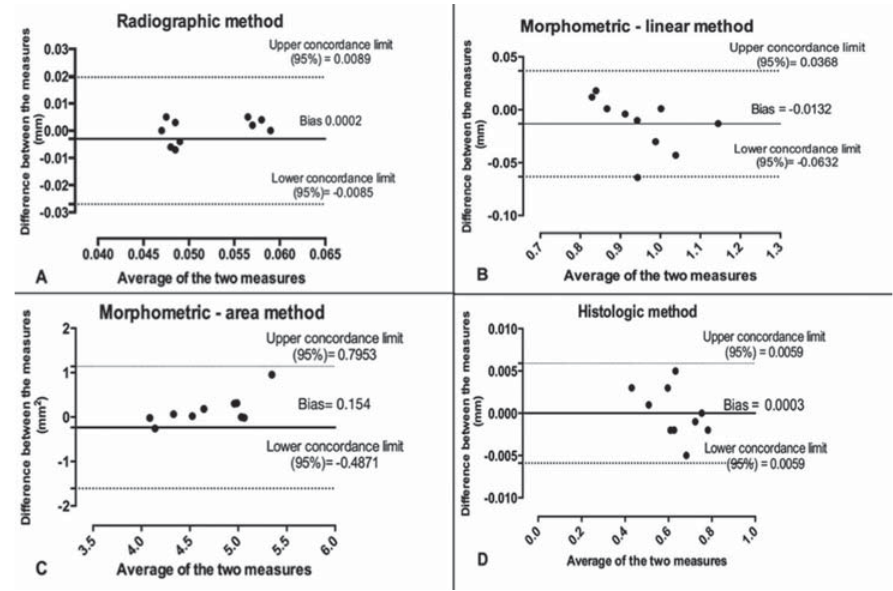
Figure 4- (cid:3)(cid:37)(cid:79)(cid:68)(cid:81)(cid:71)(cid:177)(cid:36)(cid:79)(cid:87)(cid:80)(cid:68)(cid:81)(cid:182)(cid:86)(cid:3)(cid:87)(cid:72)(cid:86)(cid:87)(cid:3)(cid:11)(cid:76)(cid:81)(cid:87)(cid:85)(cid:68)(cid:16)(cid:72)(cid:91)(cid:68)(cid:80)(cid:76)(cid:81)(cid:72)(cid:85)(cid:3)(cid:72)(cid:89)(cid:68)(cid:79)(cid:88)(cid:68)(cid:87)(cid:76)(cid:82)(cid:81)(cid:12)(cid:29)(cid:3)(cid:11)(cid:36)(cid:12)(cid:3)(cid:85)(cid:68)(cid:71)(cid:76)(cid:82)(cid:74)(cid:85)(cid:68)(cid:83)(cid:75)(cid:76)(cid:70)(cid:3)(cid:80)(cid:72)(cid:87)(cid:75)(cid:82)(cid:71)(cid:30)(cid:3)(cid:11)(cid:37)(cid:12)(cid:3)(cid:80)(cid:82)(cid:85)(cid:83)(cid:75)(cid:82)(cid:80)(cid:72)(cid:87)(cid:85)(cid:76)(cid:70)(cid:18)(cid:79)(cid:76)(cid:81)(cid:72)(cid:68)(cid:85)(cid:3)(cid:80)(cid:72)(cid:87)(cid:75)(cid:82)(cid:71)(cid:30)(cid:3)(cid:11)(cid:38)(cid:12)(cid:3)(cid:80)(cid:82)(cid:85)(cid:83)(cid:75)(cid:82)(cid:80)(cid:72)(cid:87)(cid:85)(cid:76)(cid:70)(cid:18) (cid:68)(cid:85)(cid:72)(cid:68)(cid:3)(cid:80)(cid:72)(cid:87)(cid:75)(cid:82)(cid:71)(cid:30)(cid:3)(cid:68)(cid:81)(cid:71)(cid:3)(cid:11)(cid:39)(cid:12)(cid:3)(cid:75)(cid:76)(cid:86)(cid:87)(cid:82)(cid:79)(cid:82)(cid:74)(cid:76)(cid:70)(cid:68)(cid:79)(cid:3)(cid:80)(cid:72)(cid:87)(cid:75)(cid:82)(cid:71)